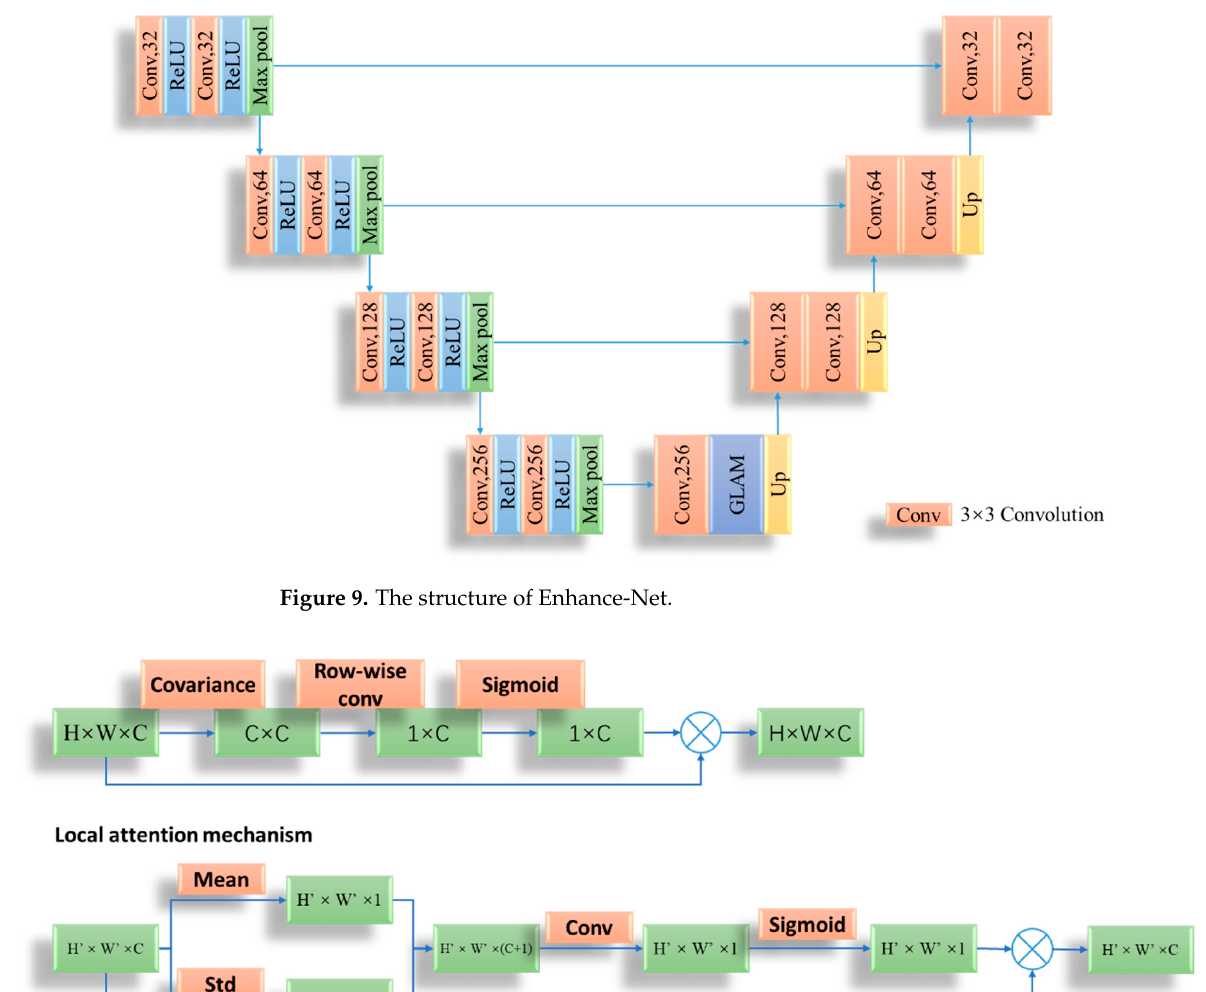
Figure 10. The detail architecture of